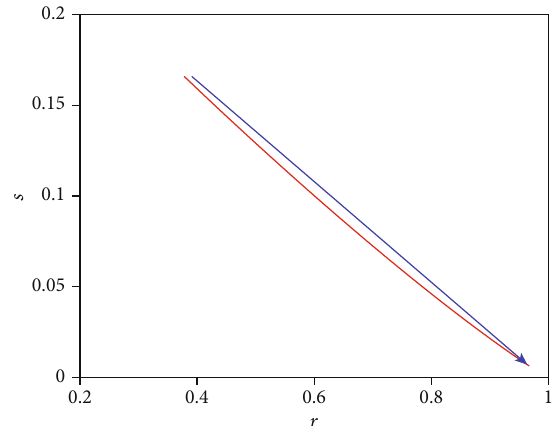
Figure 6: The plot of r − s for constants l = 1 : 5 , n = 2 , k = 0 : 5 , and = 0 : 5 . m 1